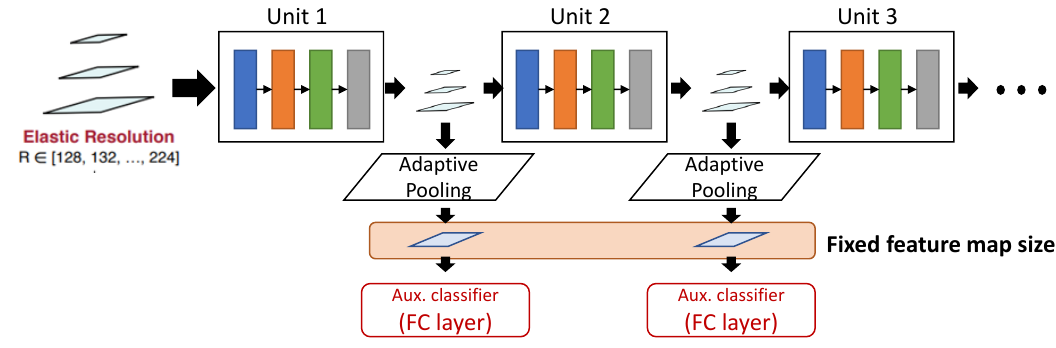
Figure 2. Adaptive pooling as a glue to attach auxiliary classifiers to SuperNet.